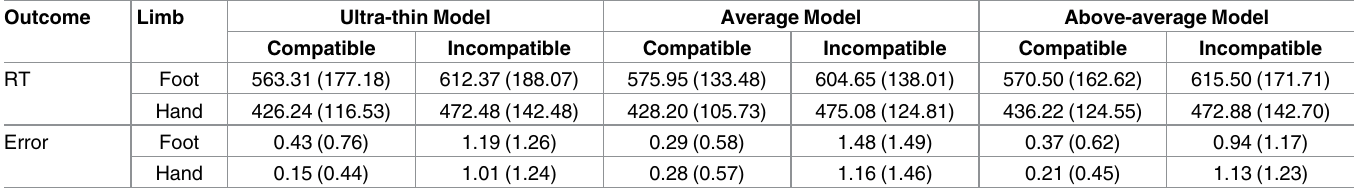
Table 1. Mean (SD) of response time (ms) and response errors collapsed across social comparison